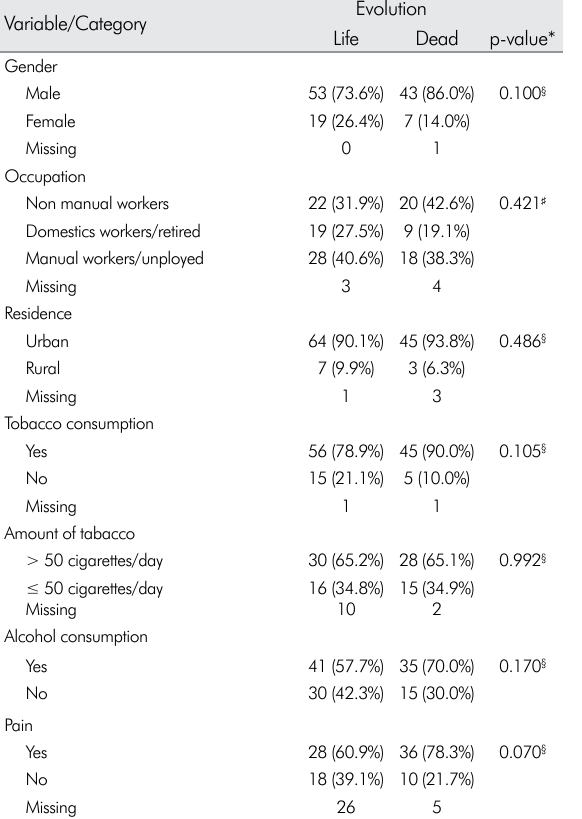
Table 4. Association between evolution and variables. (N = 123)